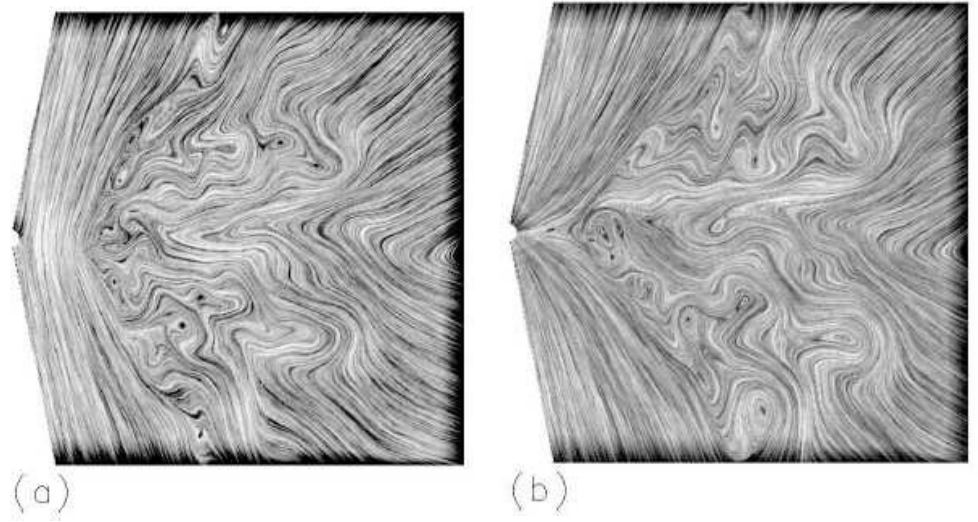
Figure 5. Snapshot of magnetic lines in model with β ing = 100, at two subsequent moments. The BH is located on the left and small open circle corresponds to the inner boundary around the black hole at R in = 2 R g . The axis of rotation is in the vertical direction. The domain in the figure has a radial size 100 R g along the equatorial plane and represents a fraction of the full computational domain with R out = 220 R g . The poloidal field lines lying in the meridional plane are shown. The accretion disk transports the vertical magnetic flux inward, which is accumulated in the vicinity of a BH. Small-scale magnetic loops are the result of turbulent motions in the disk and disk corona. ( a ) Period of accretion, in which most of the accumulated magnetic flux is outside the black hole horizon. ( b ) Accretion period, in which all the accumulated flux goes through the horizon,